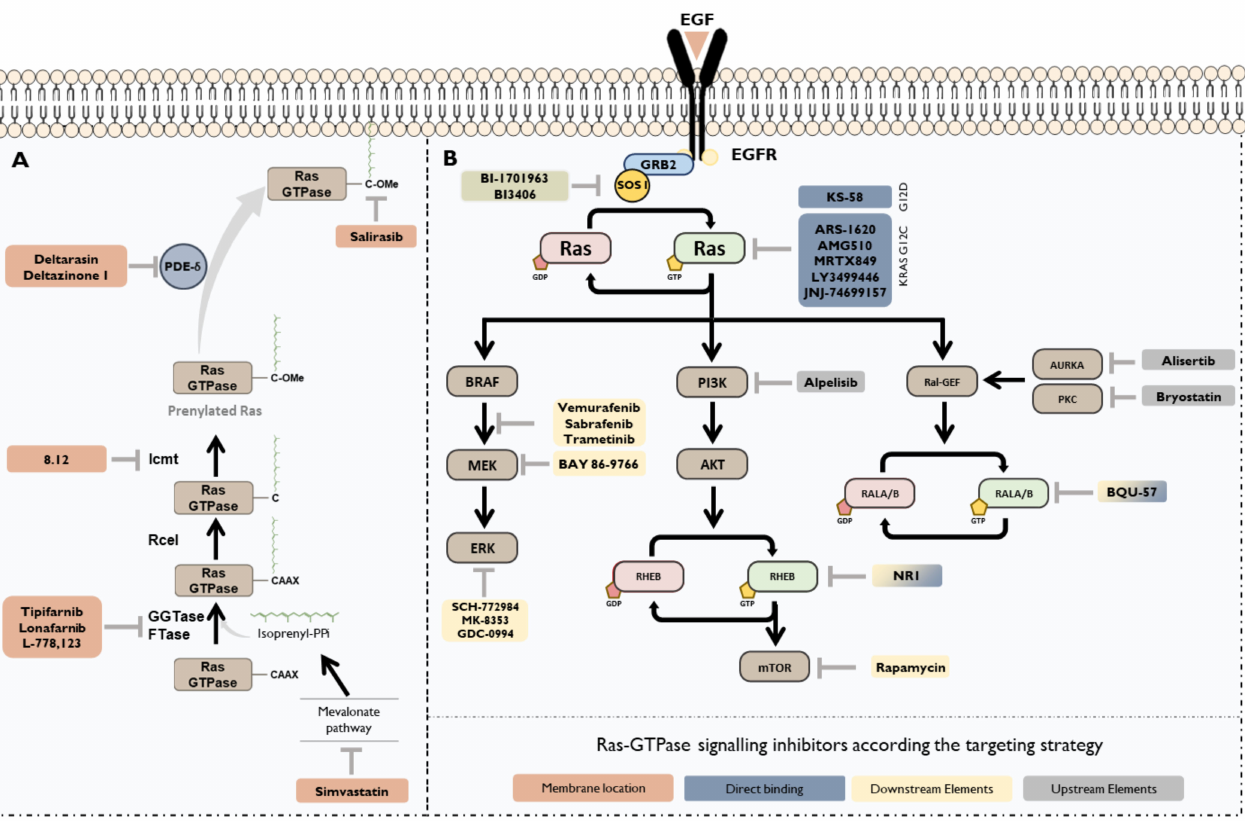
Figure 4. Current strategies for targeting RAS-GTPases in CRC. ( A ) Targeting Ras membrane location. Inhibition of Ras prenylation or its coupling to plasma membrane has been used both in preclinical and clinical trials for treating KRAS mutated tumours. ( B ) Targeting Ras family members directly or its upstream or downstream